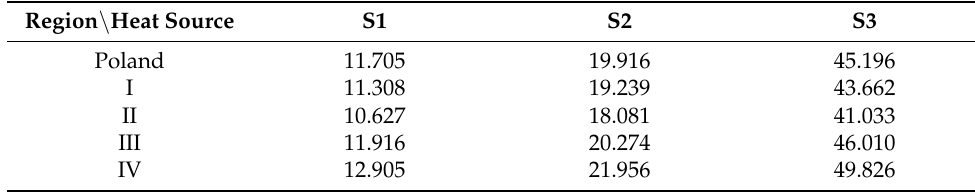
Table 5. Annual economic heating costs G 0 [(PLN · K)/(W · year)].